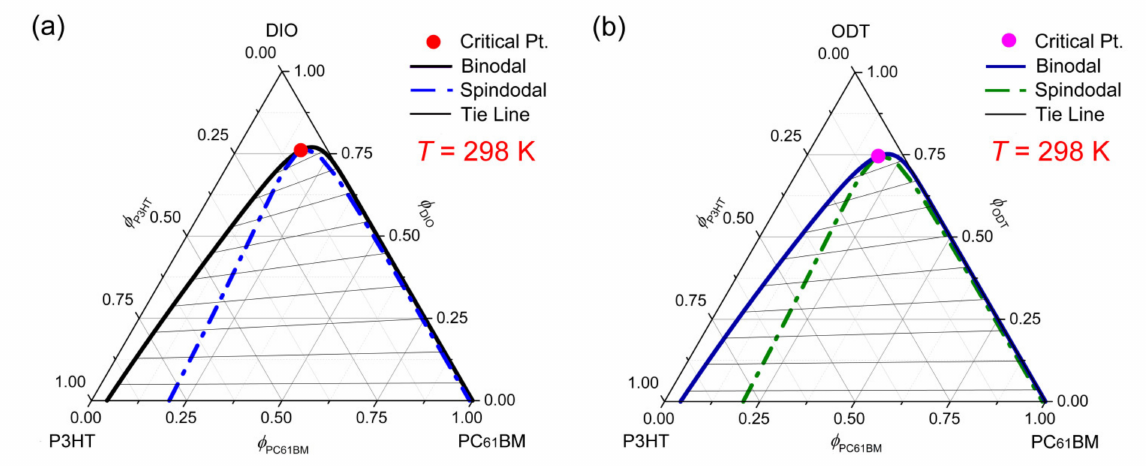
Figure 6. Phase diagrams of the ternary systems at constant T = 298 K. ( a ) DIO/P3HT/PC 61 BM: χ 12 = 0.42, χ 13 = 1.73, χ 23 = 2.47, s = 0.009344 and r = 0.307858. ( b ) ODT/P3HT/PC 61 BM: χ 12 = 0.39, χ 13 = 1.84, χ 23 = 2.44, s = 0.009196 and r = 0.302998. Here DIO and ODT stand for 1,8-diiodooctane and 1,8-octandithiol,